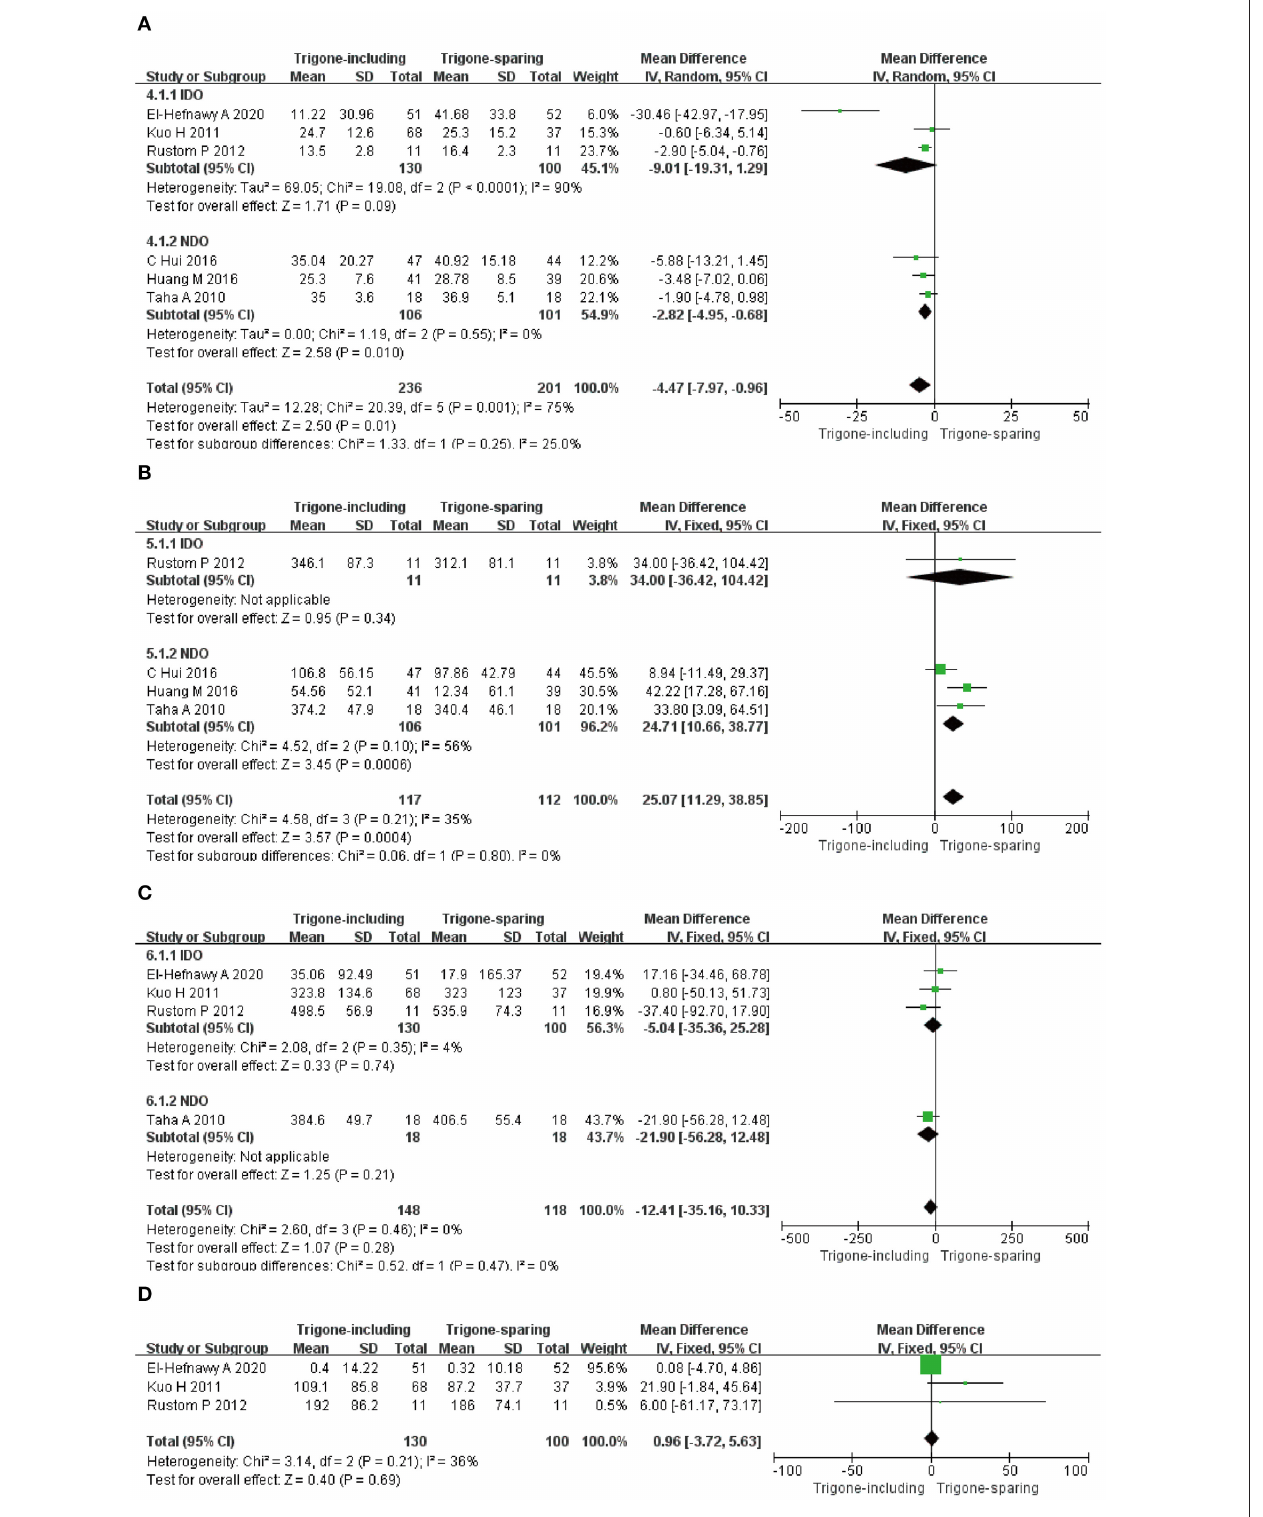
Frontiers in Neurology |